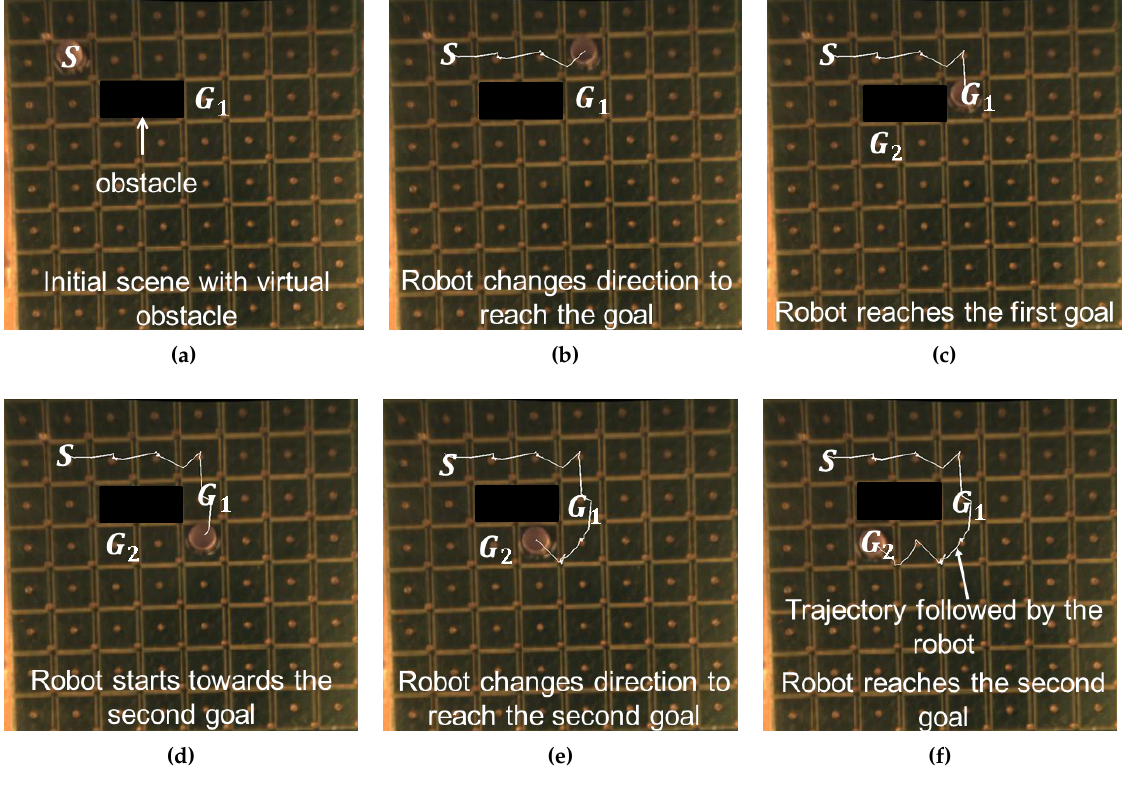
Figure 7. Autonomous navigation of a robot towards two goal locations on an array of 64 microcoils: ( a ) initial scene with the robot and goal location; ( b ) robot reaches a waypoint on its way to the first goal location G 1 ; ( c ) robot changes direction to reach the first goal location; ( d ) robot starts moving to the second goal location G 2 ; ( e ) robot changes direction towards the second goal location G 2 ; ( f ) robot reaches the second goal location G 2 . The trajectory followed by the robot is marked with white